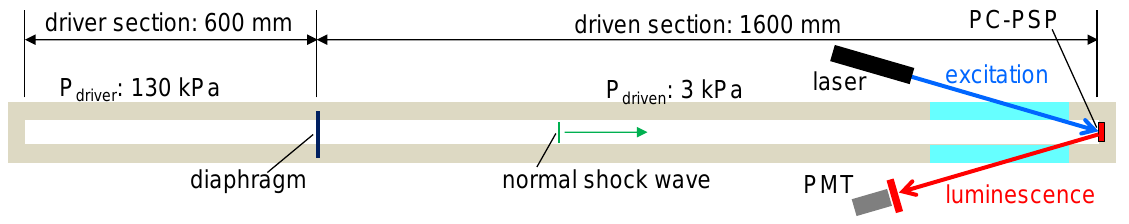
Figure 5. Schematic of the shock tube